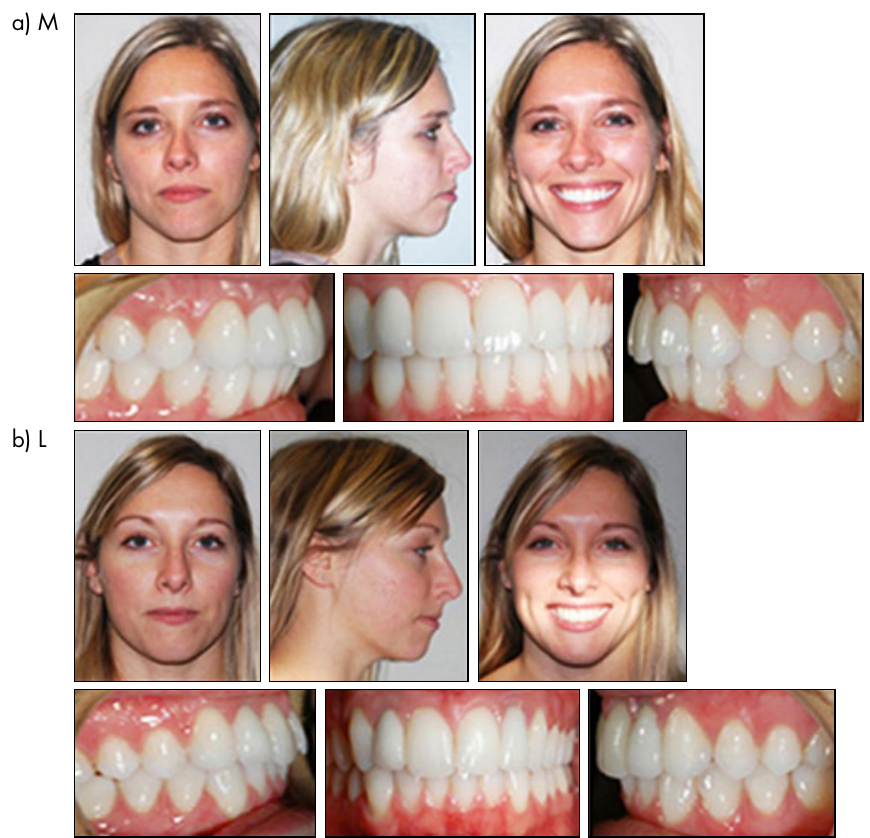
Figure 17. Facial and Intraoral Photographs taken after replacement of Maryland bridges with implants for the upper lateral incisors at age 29 (15 years,